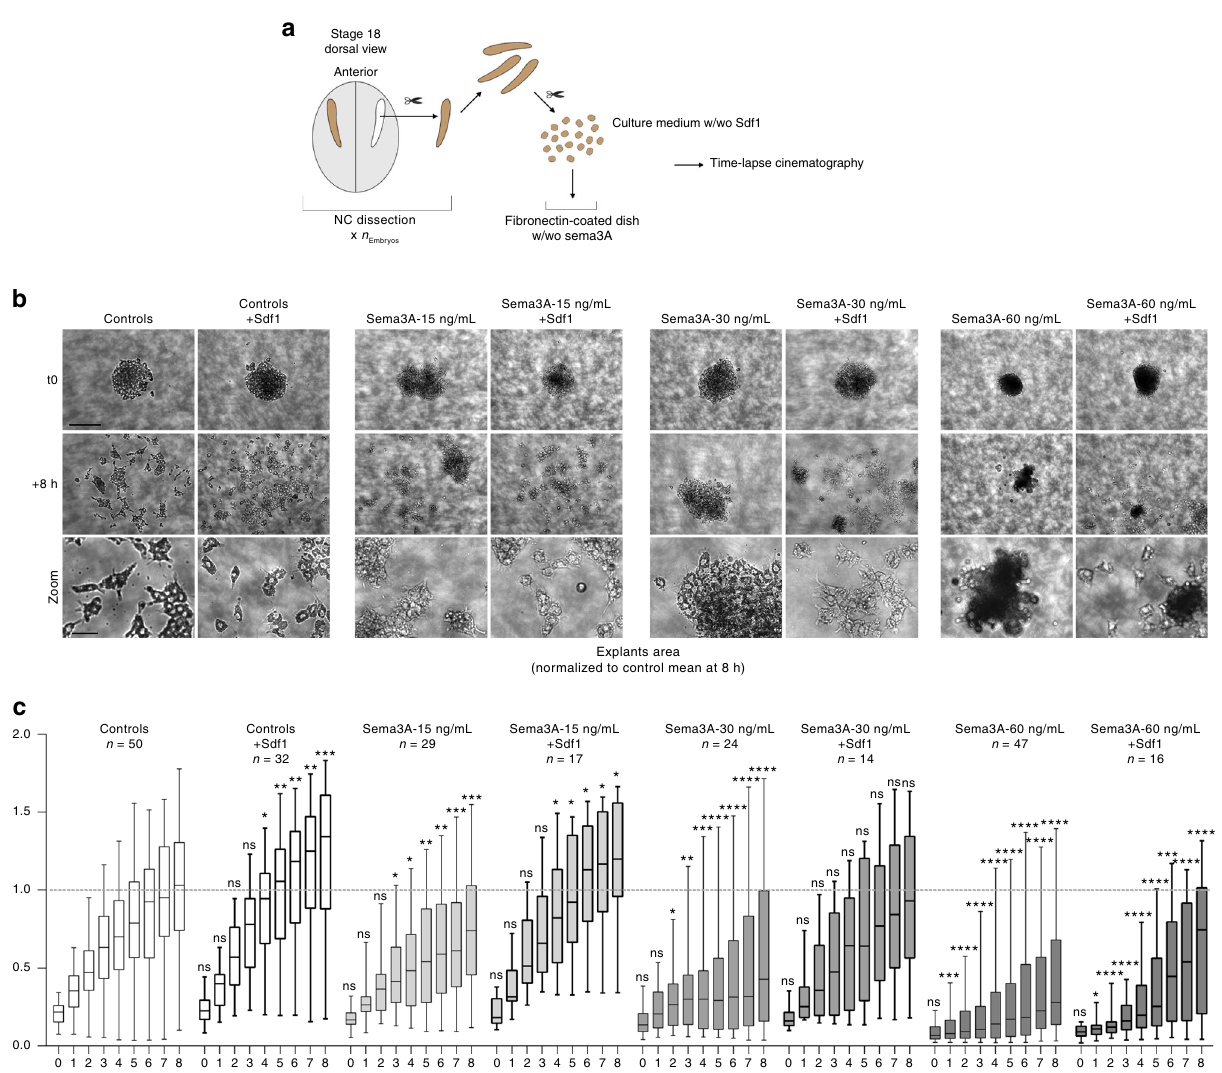
Fig. 3 Sdf1 and Sema3A have antagonistic effects on cell dispersion. a Diagram explaining how NC explants were prepared. b Representative examples of explants at t0 (one hour after plating on Fibronectin) and + 8 h. Note that cells exposed to Sema3A have a round morphology and tend to stay as small clusters, even when dispersion is rescued by Sdf1. c Distribution of explants areas per hour per experimental condition. A total of 229 explants ( n controls = 50; n Sdf1 = 32; n Sema3A-15ng.mL = 29; n Sema3A-15ng.mL + Sdf1 = 17; n Sema3A-30ng.mL = 24; n Sema3A-30ng.mL + Sdf1 = 14; n Sema3A-60ng.mL = 47; and n Sema3A-60ng.mL + Sdf1 = 16) from fi ve independent experiments were used. Two-way ANOVA, matching: stacked, pairwise multiple comparisons. * p value < 0.05; ** p value < 0.01; *** p value < 0.001; **** p value < 0.0001. Dotted line on the graphs represents the mean value for controls at 8 h, provided as a visual reference for comparison with other conditions. Scale bar on low magni fi cation, 100 μ . Scale bar on zooms, 20 μ . Box and whiskers plot: the box extends from the 25th to the 75th percentile; the whiskers show the extent of the whole dataset. The median is plotted as a line inside the box. Source data are provided as a Source Data fi